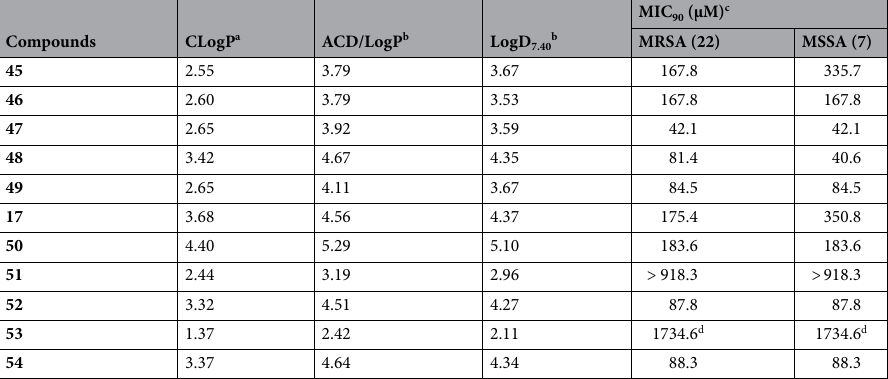
Table 5. Physico-chemical parameters and antimicrobial activities of compounds 17 , and 45 to 54 14 . a The CLogP values were calculated using software ChemBioDraw Ultra 12.0. b The ACD/Log P and LogD 7.40 values were calculated using software ACD/Labs 6.0. c MIC 90 , minimum inhibitory concentration to 90% test isolates; MRSA (22), twenty-two isolates of methicillin-resistant Staphylococcus aureus ; MSSA (7), seven isolates of methicillin-susceptible Staphylococcus aureus. d Both MIC 90 s of compound 53 against MRSA and MSSA were more than 250 μg/mL (867.3 μM). As microdilution broth method was used to test MIC, we set 500 μg/mL (1734.6 μM) as their